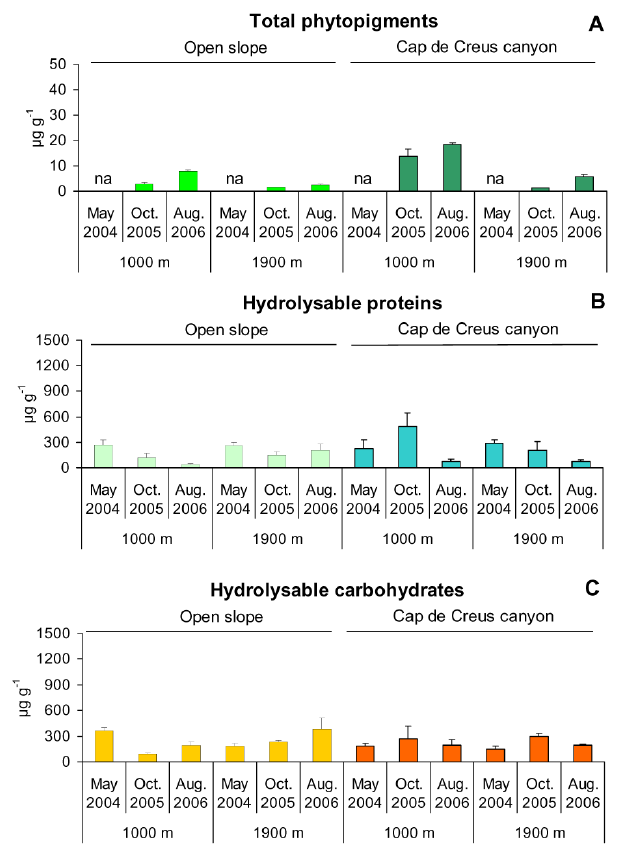
Fig. 2. Spatial distribution of (A) total phytopigment concentra- tions, (B) enzymatically hydrolysable protein and (C) carbohydrate pools in surface sediments of the Cap de Creus canyon and adjacent open slope of the Catalan margin collected in the different sampling periods. na = not available. Standard deviations are